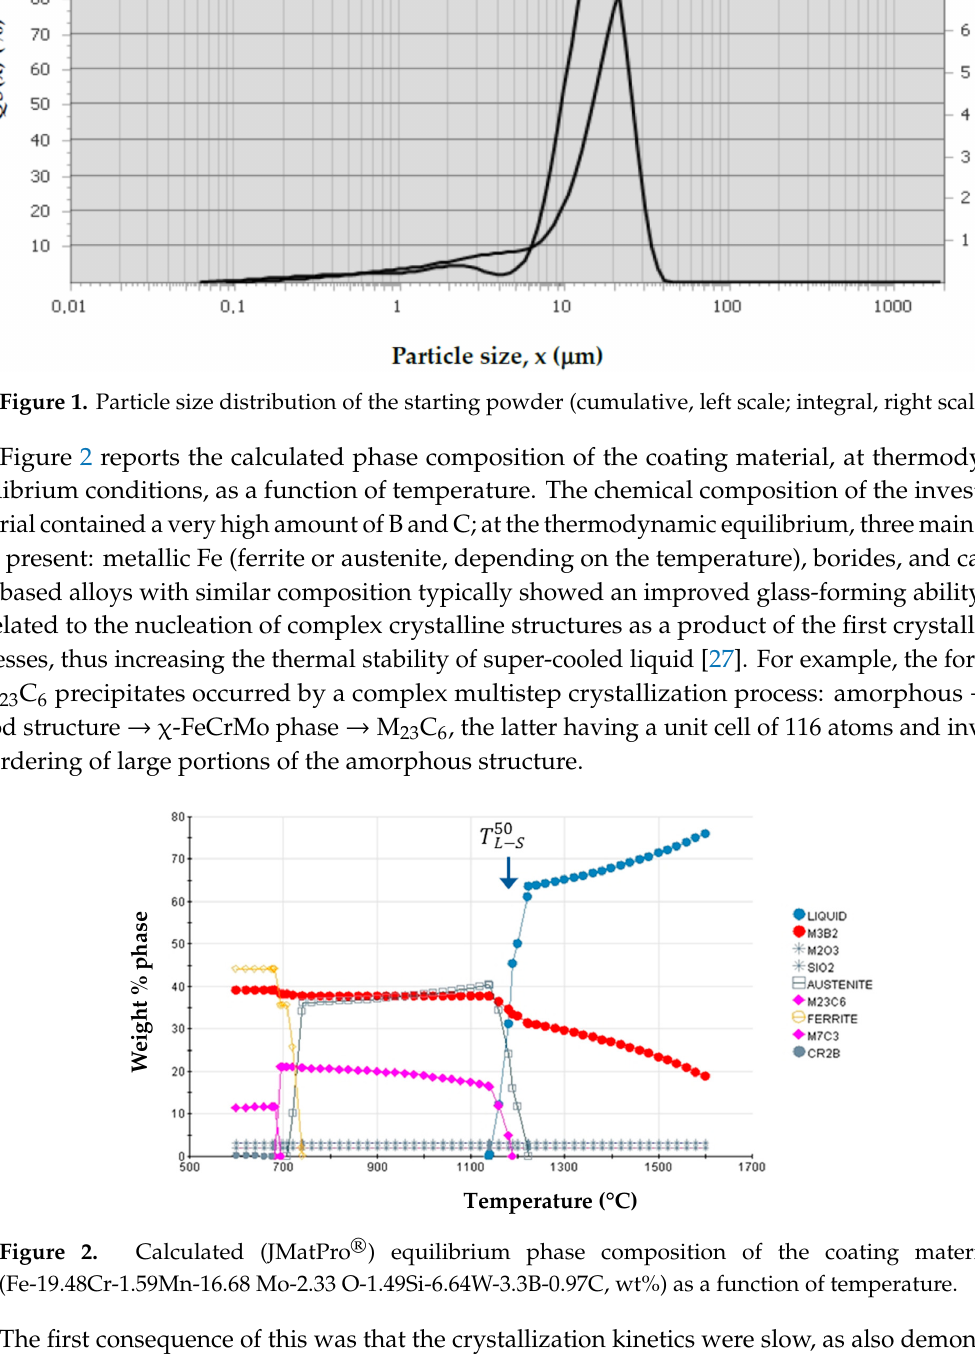
Figure 2. Calculated (JMatPro®) equilibrium phase composition of the coating material (Fe-19.48Cr-1.59Mn-16.68 Mo-2.33 O-1.49Si-6.64W-3.3B-0.97C, wt%) as a function of